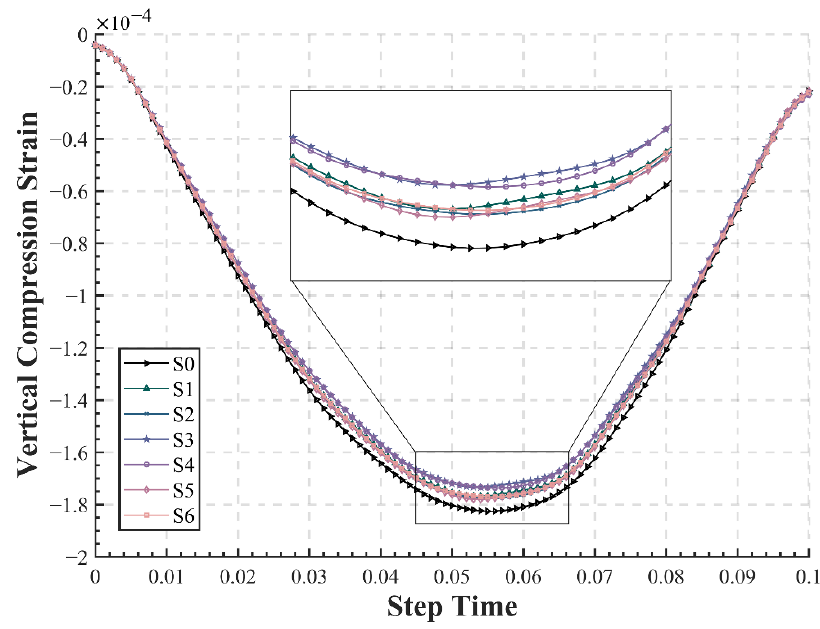
Figure 9. Time–history curve of vertical compressive strain on the top of subgrade.